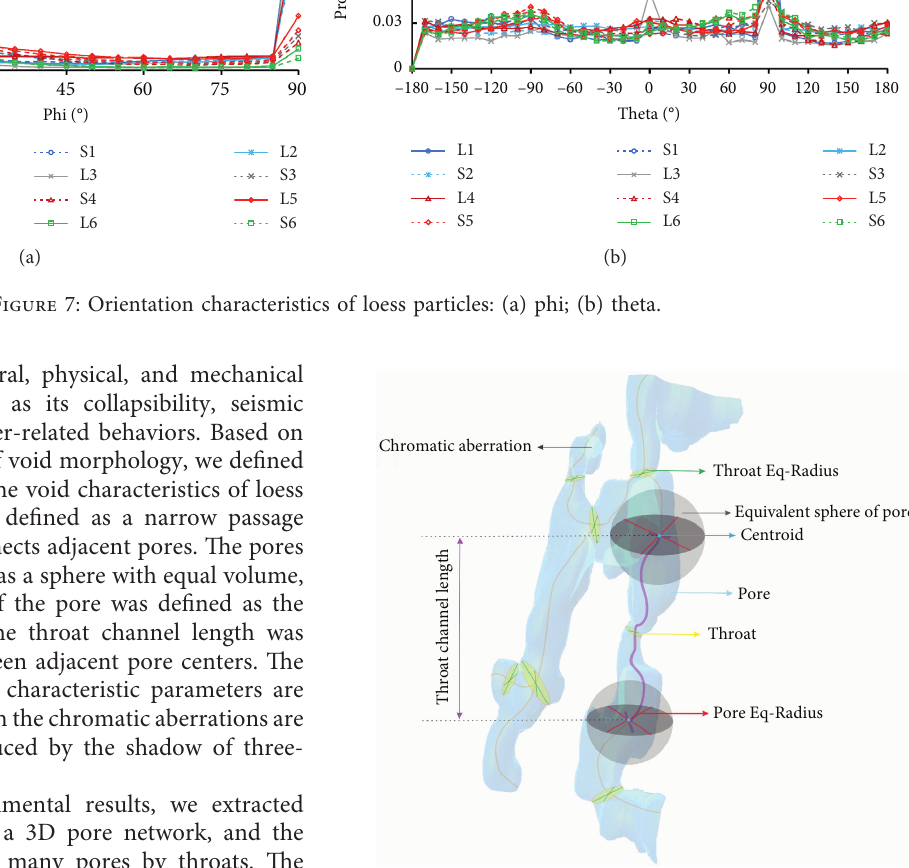
Figure 8: Definition of the characteristic parameters of loess voids.